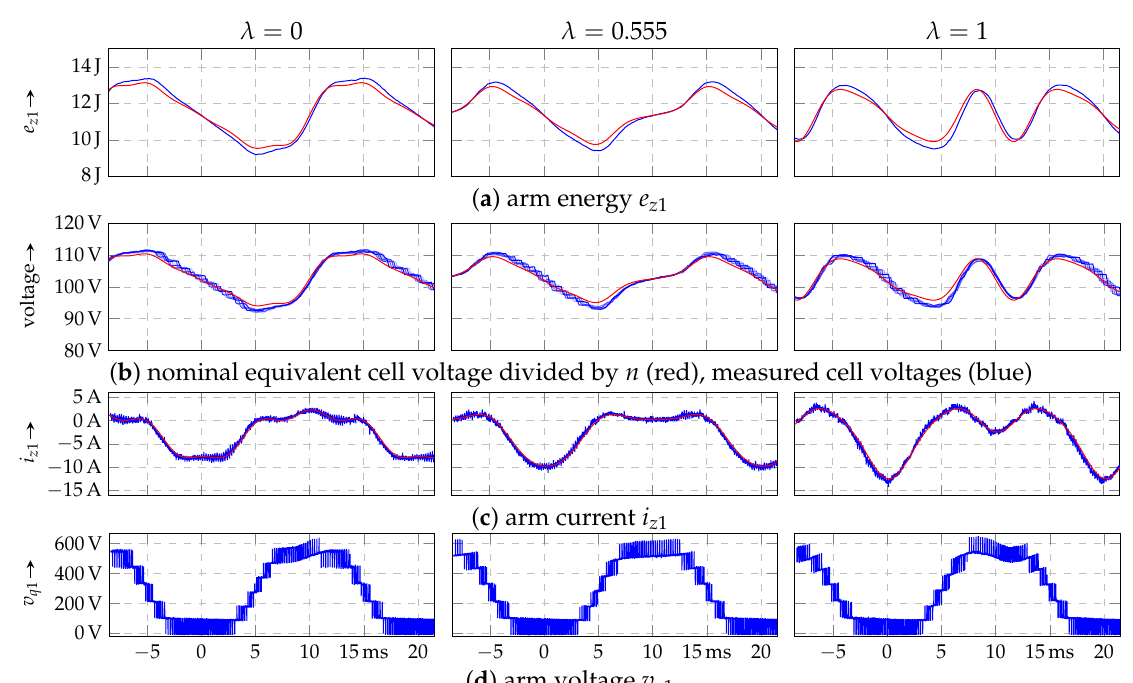
0,0.555,1 for a low-voltage MMC with R z = 166.9m Ω , ∈ { }